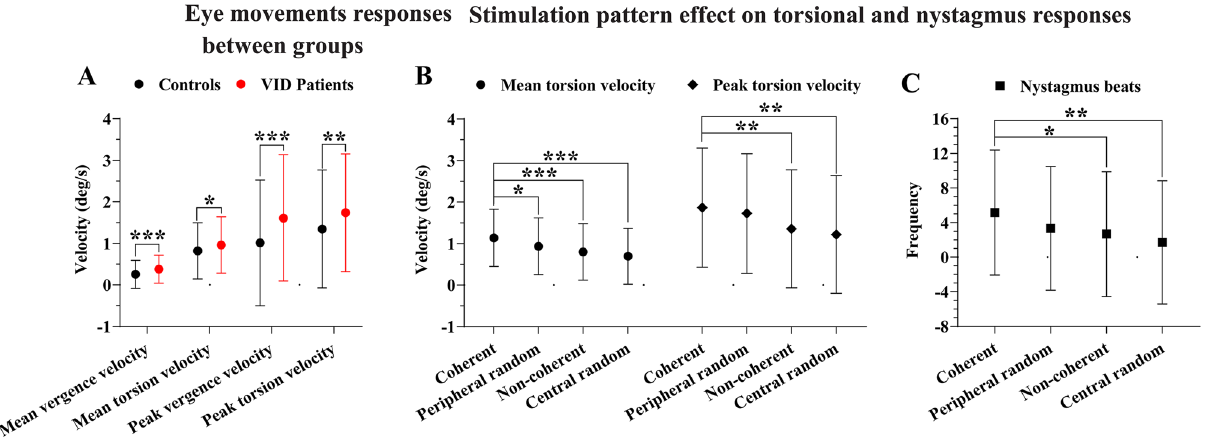
Figure 3. ( A ) An interval plot illustrating the optokinetic slow-phase responses velocities as absolute values (degrees per second), and the 95% confidence interval (error bars), between healthy individuals and concussed individuals with VID. ( B ) Interval plot illustrating the modulating effect of different optokinetic stimulation patterns over the mean torsion and peak torsion optokinetic slow-phase velocities (degrees per second), and the 95% confidence interval (error bars). ( C ) Interval plot illustrating the modulating effect of different optokinetic stimulation patterns over the number of nystagmus (frequency), and the 95% confidence interval (error bars). * p < .05; ** p < .01; *** p <